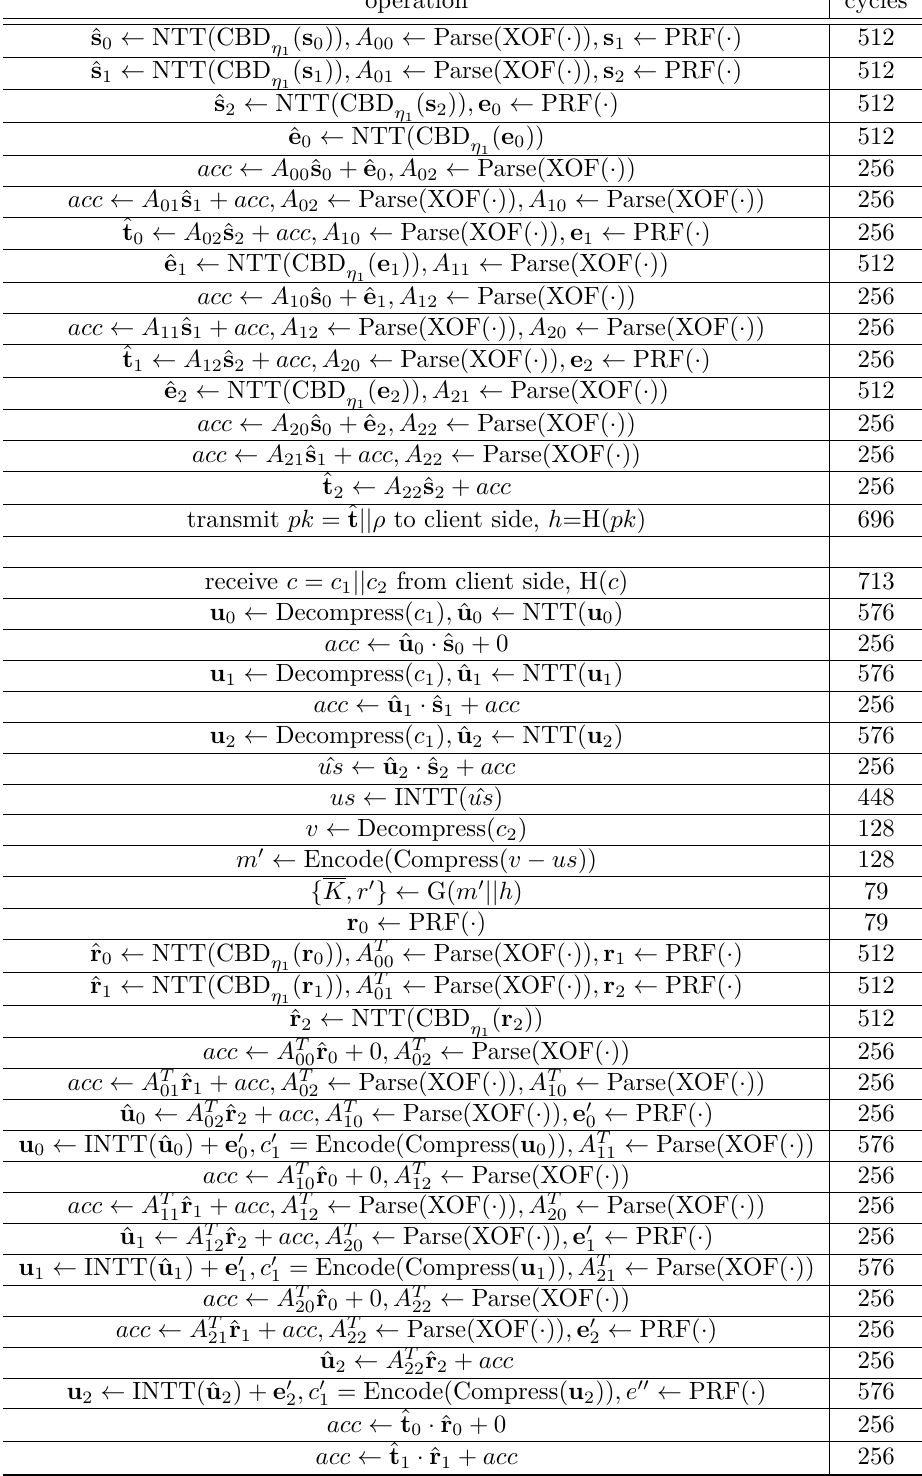
Table 8: Detailed procedures in server side and corresponding cycle counts in implementing Kyber.CCAKEM protocol when k =3